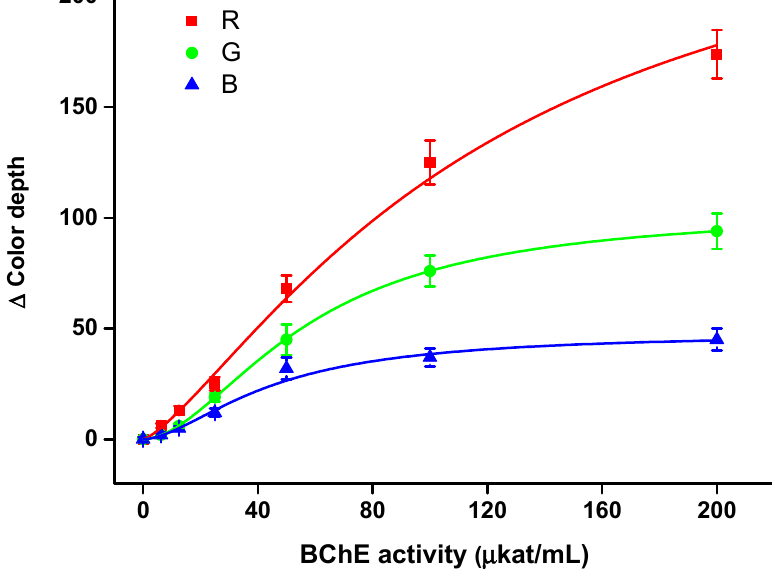
Figure 6. Calibration for butyrylcholinesterase (BChE) using the smartphone camera-based colori- metric assay with the measuring pad modified with indoxylacetate. A 60 min incubation was chosen for this experiment. Standard error of the mean is expressed for five independent repeats. R red; G green; B blue.